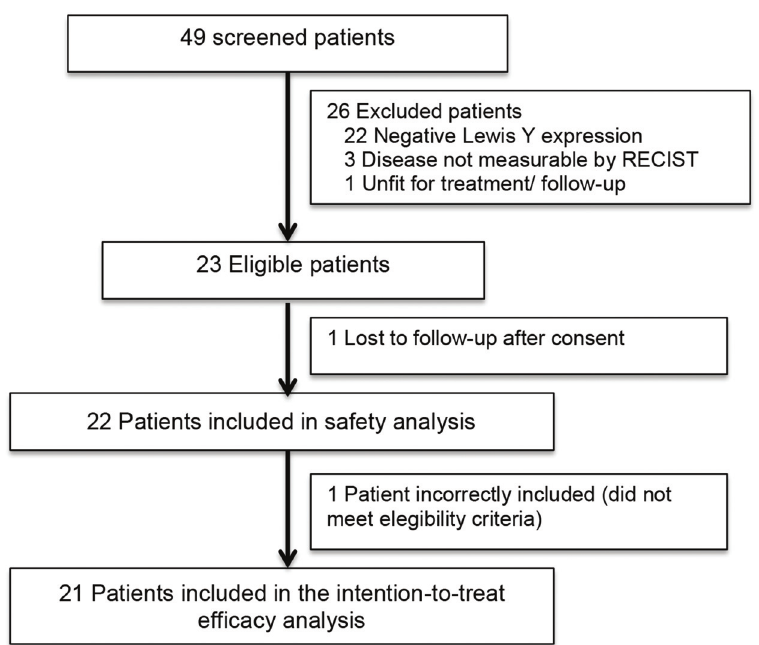
Figure 1 - CONSORT diagram. RECIST, Response Evaluation Criteria in Solid Tumors.